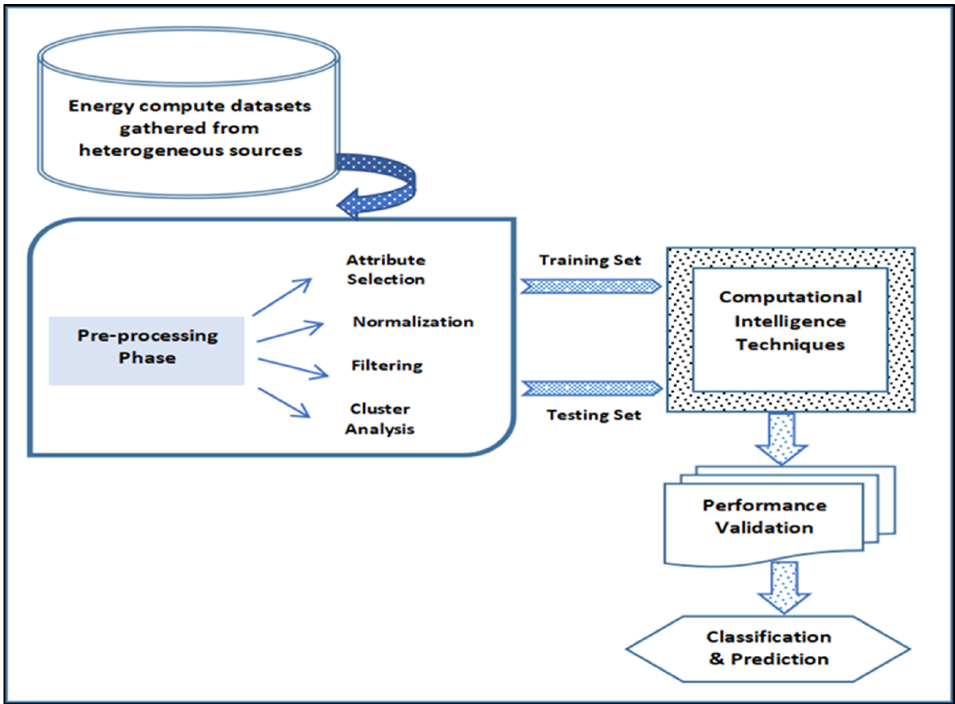
Figure 1. A generalized computational intelligence model for energy consumption analysis.